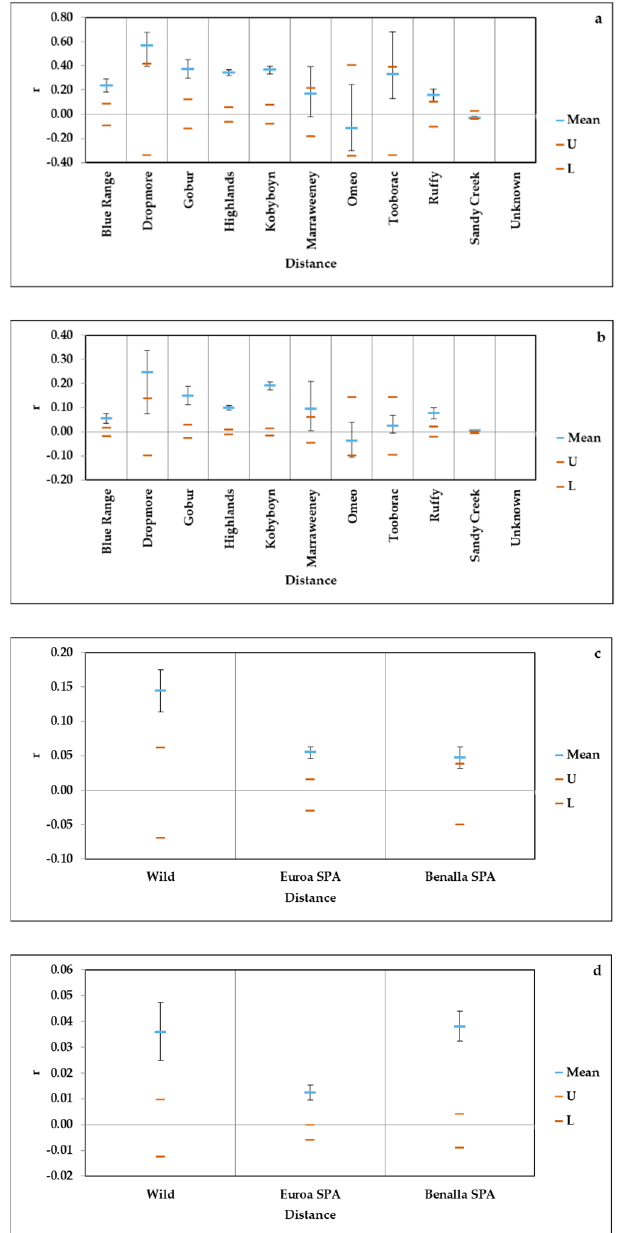
Figure 2. Mean relatedness ( r ) estimates based on pairwise comparisons for Banksia marginata using Lynch and Milligan (1994) for ( a ) remnants and for ( c ) wild and SPAs; Queller and Goodnight (1989) for ( b ) remnants and for ( d ) wild and SPAs. Mean values are the mean level of relatedness within the population. U and L are the 95% confidence intervals around the null hypothesis of ‘No difference’ across the populations. Black lines with error bars are the observed mean relatedness and standard deviation for each